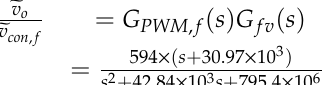
Figure 15. Control block diagram of the output voltage